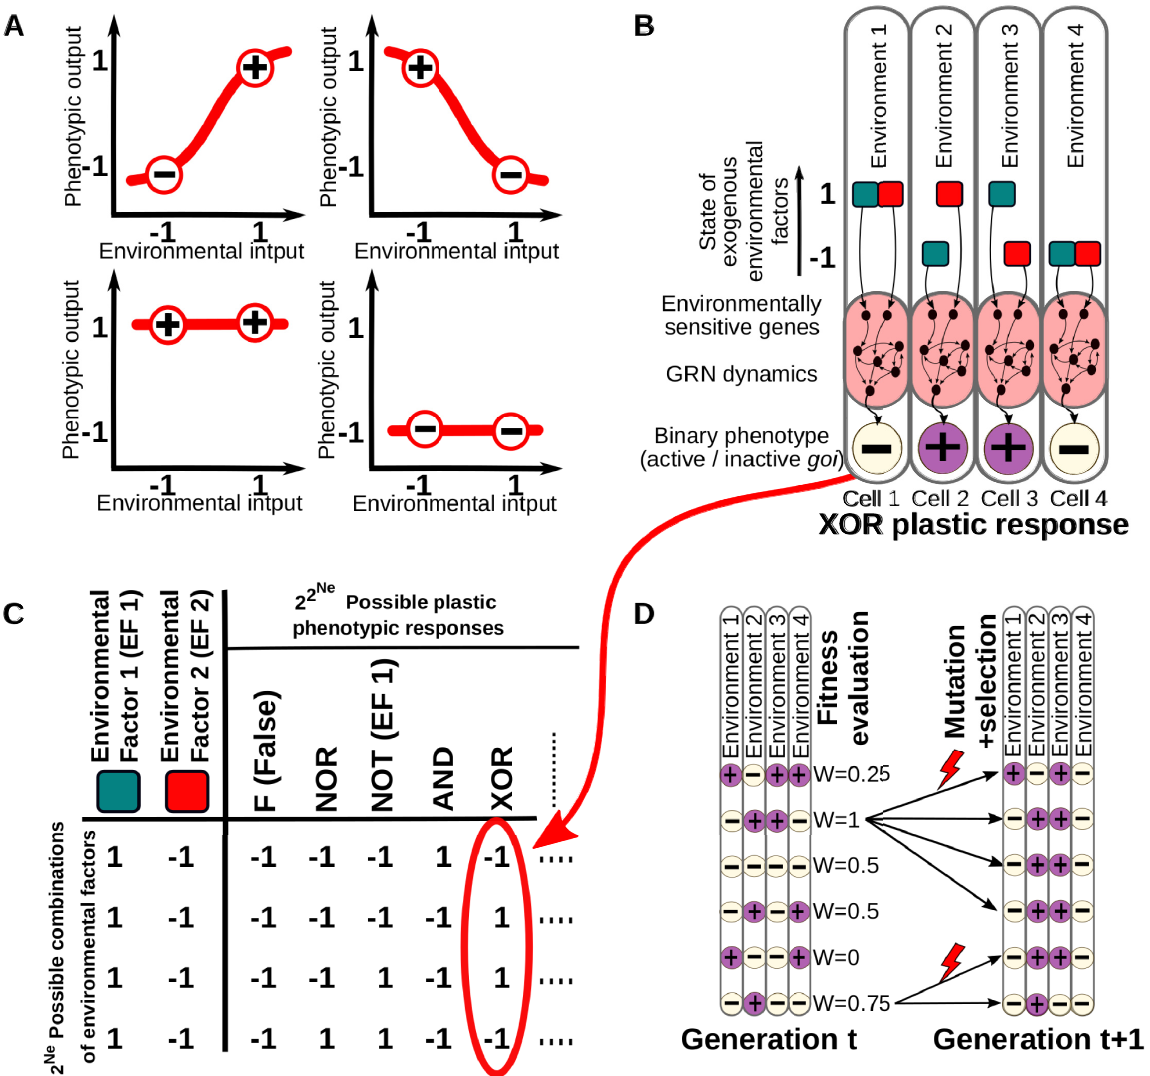
Fig 1. Conceptual depiction of the model. A. Models of phenotypic and cell plasticity often depict a 1-dimensional reaction norm (red line), for a single continuous environmental cue. B. In contrast, we consider different combinations of Ne discrete environmental factors (in this illustrative example, Ne = 2 , red and blue in the figure) determining a binary cell state. In this case, a number of possible environment-phenotype interactions can be described by means of logical functions derived from Boolean algebra (right). C. Five examples of multi-dimensional reaction norms in which the expression level of some gene is affected by the Ne environmental factors. One of these multi-dimensional reaction norms (e.g. the one described by the “XOR” logical function depicted in B) is set as a target of a continuous GRN-based model. D. The degree of matching between the plastic response of the cells and the expected target multi-dimensional reaction norm determines the fitness (see Methods). Plastic cells reproduce into the next generations with a probability proportional to their fitness in a mutation-selection scenario.